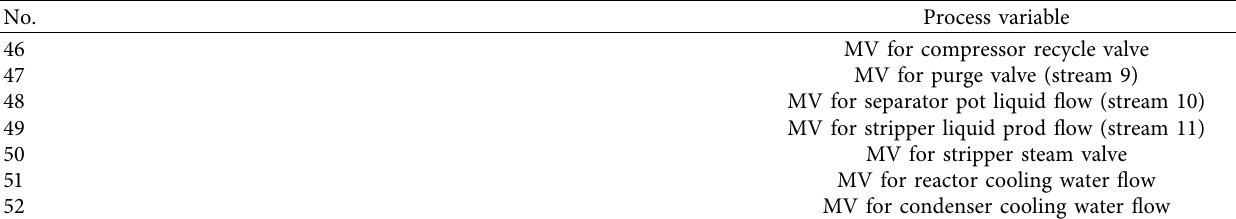
Table 2: Faults description for the TE process.